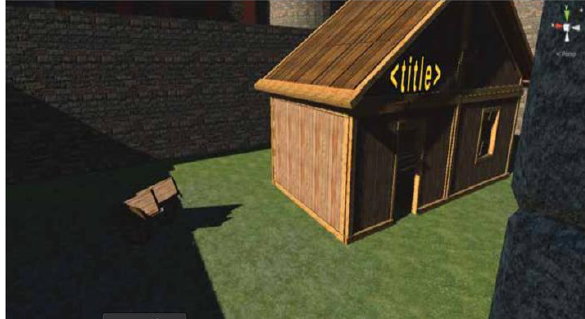
Figure 10: Cabin representing the <title> tag.